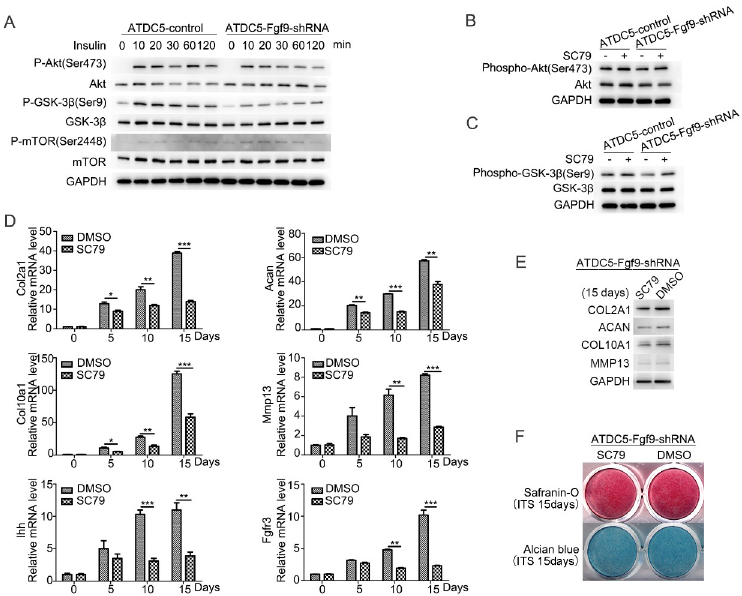
Fig 4. FGF9 silencing inhibits insulin-induced AKT/ GSK-3 β pathway activation which participating in the differentiation of the ATDC5 cells. FGF9 silencing inhibits insulin-induced AKT and GSK-3 β phosphorylation in the ATDC5 cells which was detected by Western blotting (A). Insulin-induced phosphorylation of AKT and GSK-3 β in ATDC5-FGF9-shRNA cells is compensated by SC79 (B/C). When SC79 was added to the differentiation medium, the mRNA expression of chondrogenic markers Col2a1, Acan, Col10a1, Ihh, Mmp13 and FGFR3 were downregulated (D). The protein levels of Col2a1, Acan, Col10a1, Mmp13 were detected by Western blotting (E) on the induction day 15 with or without SC79, as well as cartilage matrix deposition by Safranin-O staining and Alcian blue staining (F). ( � P < 0.05; �� P < 0.01; ��� P < 0.005).